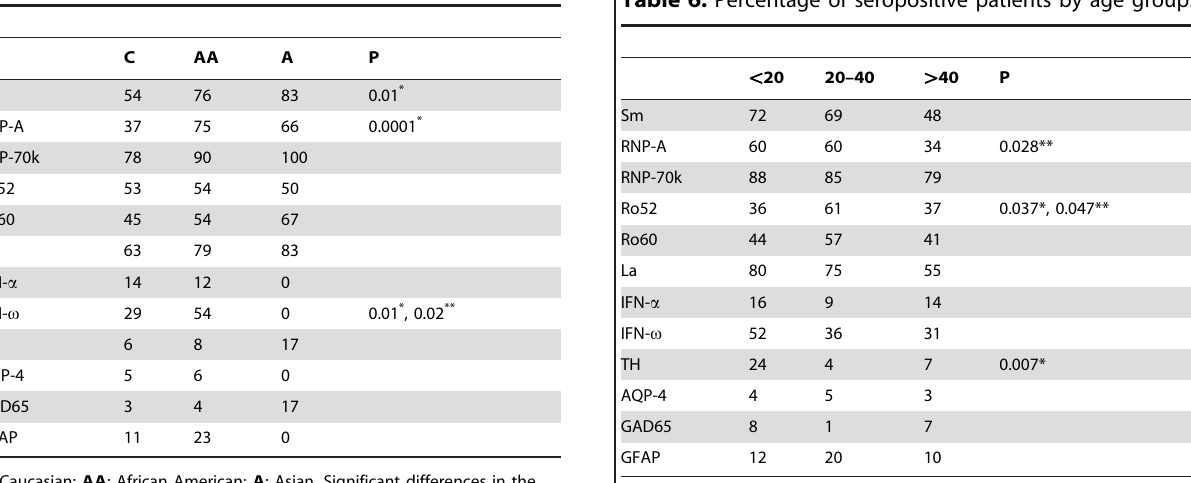
Table 5. Percentage of seropositive patients by ethnicity.